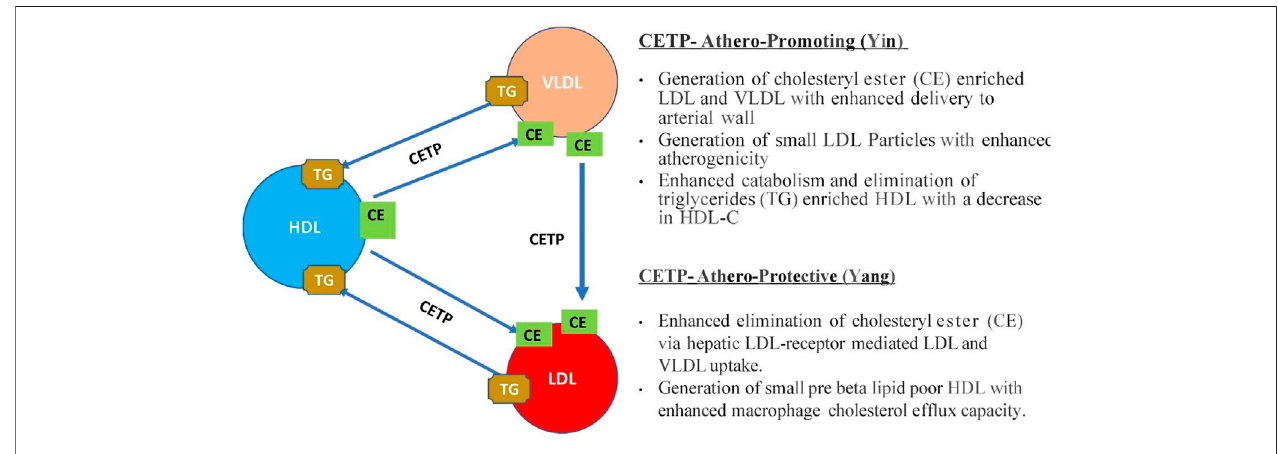
FIGURE2| ShowstheYinandYangofCETPinatherosclerosis.CEtransferfromHDLparticlestoLDL-VLDLparticlesisfacilitatedbyCETPinexchangeforTGand CETP also facilitates CE movement from VLDL to LDL particles.